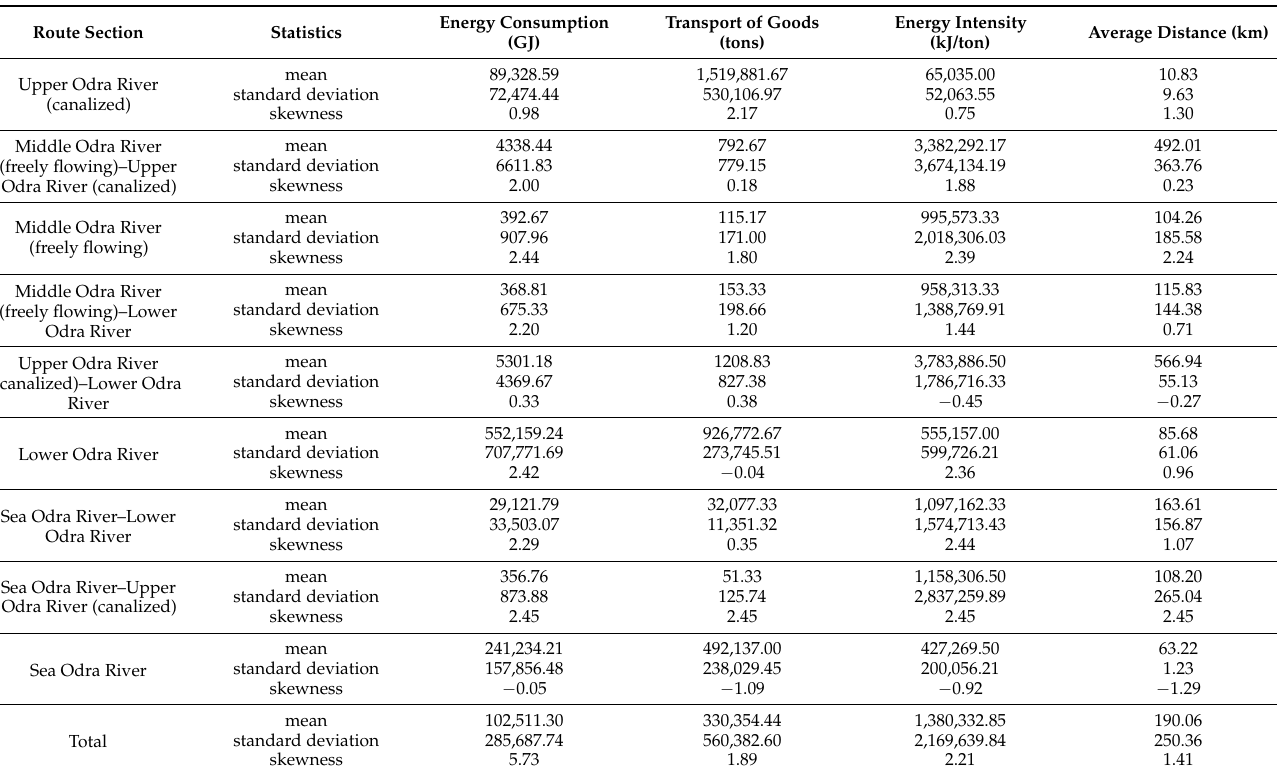
Table 4. Selected summary statistics of inland waterway transport features by sections of the Odra Table 4 presents selected descriptive statistics of the studied variables in particular sections of the Odra River. Based on selected descriptive statistics of features for the Odra River and its sections, River in it was calculated that the average energy consumption by inland waterway transport is